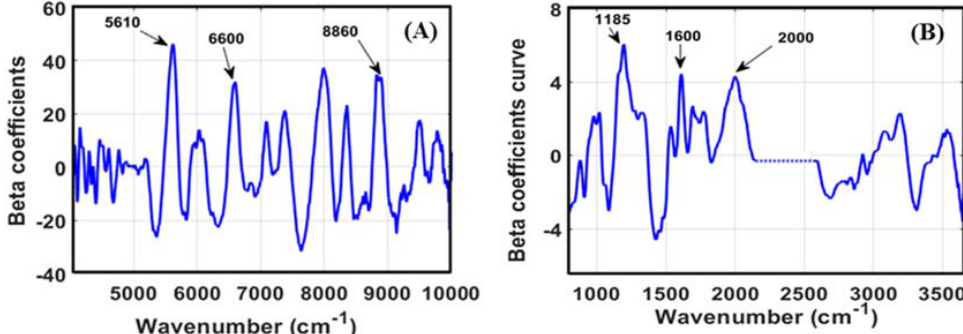
Figure 4. The regression coefficient of the PLSR model for isoflavones prediction using FT-NIR ( A ) and FT-IR ( B ). ( A ) and FT-IR ( B ). Figure 4B locates a specific band of FT-IR spectral data for isoflavone detection. All